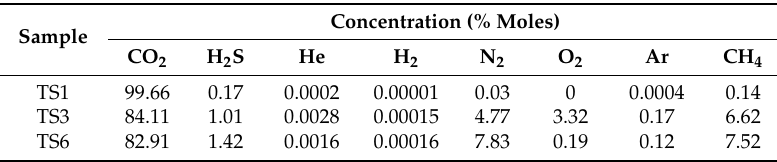
Figure 10. Variation in δ 13 C CO2 levels of different origins. Relative concentration of δ 13 C CO2 in thermal fluid from all thermal manifestations located at Tampomas Volcano. All thermal manifestations originate from four sources: atmospheric CO 2 , groundwater dissolved inorganic carbon (DIC), magmatic CO 2 and marine bicarbonate. Table 7. The non-condensable gas (NCG) concentration of dry-gas samples in some springs with ebullient characteristics.